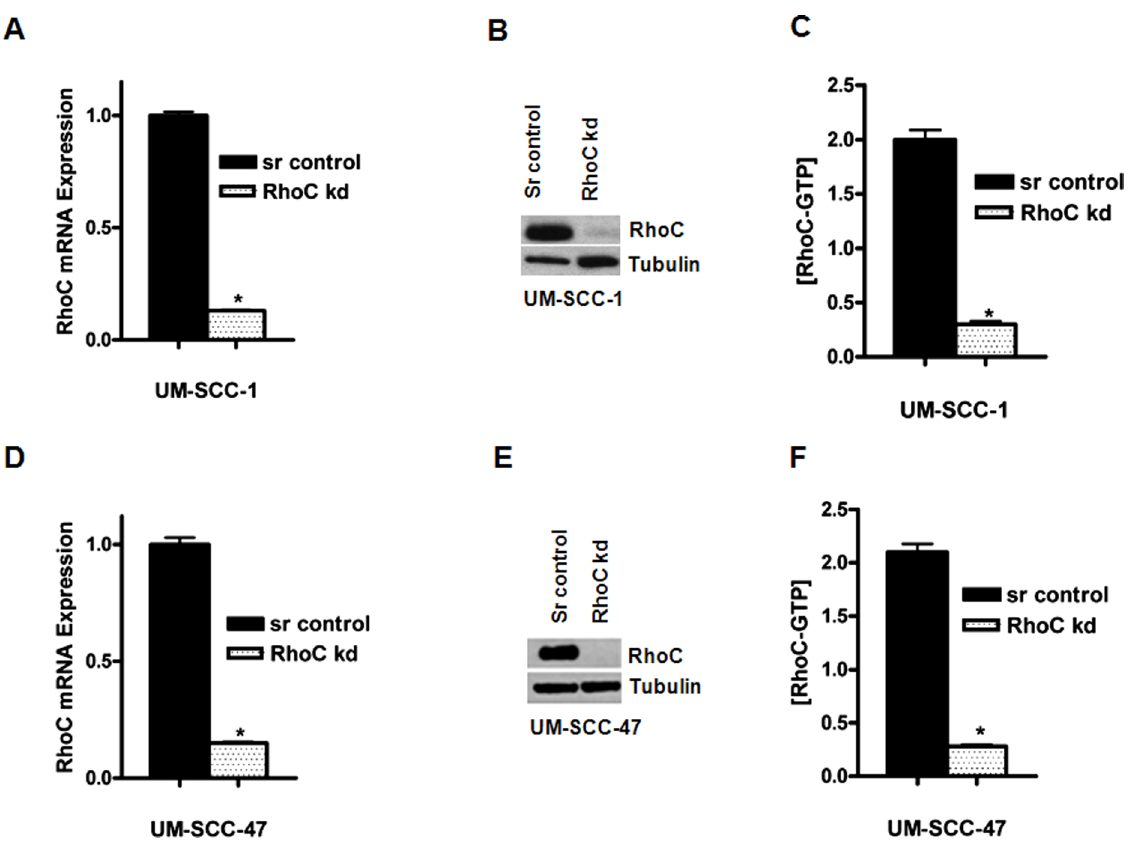
Figure 2. RhoC expression in scrambled control and RhoC knockout UM-SCC-lines. (A and D) The mRNA expression of RhoC obtained by real time RT-PCR; (B and E). Western blot analysis showing RhoC expression in the scrambled control and RhoC knockdown clones (C and F). Bar graph showing the expression of active RhoC [RhoC-GTP] in scrambled control and RhoC knockdown UM-SCC-1 and-47 respectively. A significant decrease in RhoC mRNA, protein and [RhoC-GTP] levels were obtained in the RhoC knockdown cell lines.